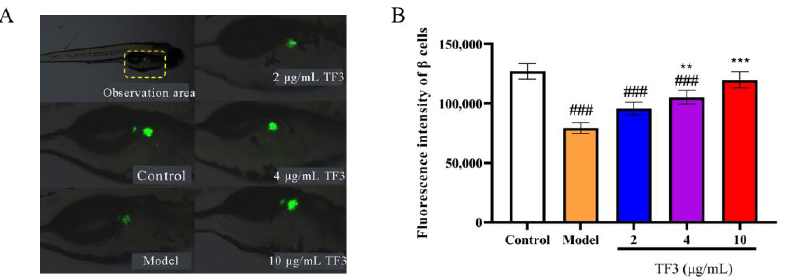
Figure 5. TF3 promoted β cell regeneration from alloxan-induced damage in zebrafish. ( A ) Fluores- cence phenotype of zebrafish β cells and ( B ) the fluorescence intensity of β cells. Data were presented as the mean ± SD. Control, water culture; model, water with 1 μM alloxan and 4% glucose culture for 24 h; TF3, water with different concentrations of TF3 (0.5, 2, 4, 6.7, 10, and 20 μg/mL) treating for 24 h after alloxan-treatment. ### p < 0.001 versus control group, ** p < 0.01 versus model group, *** p < 0.001 versus model group.